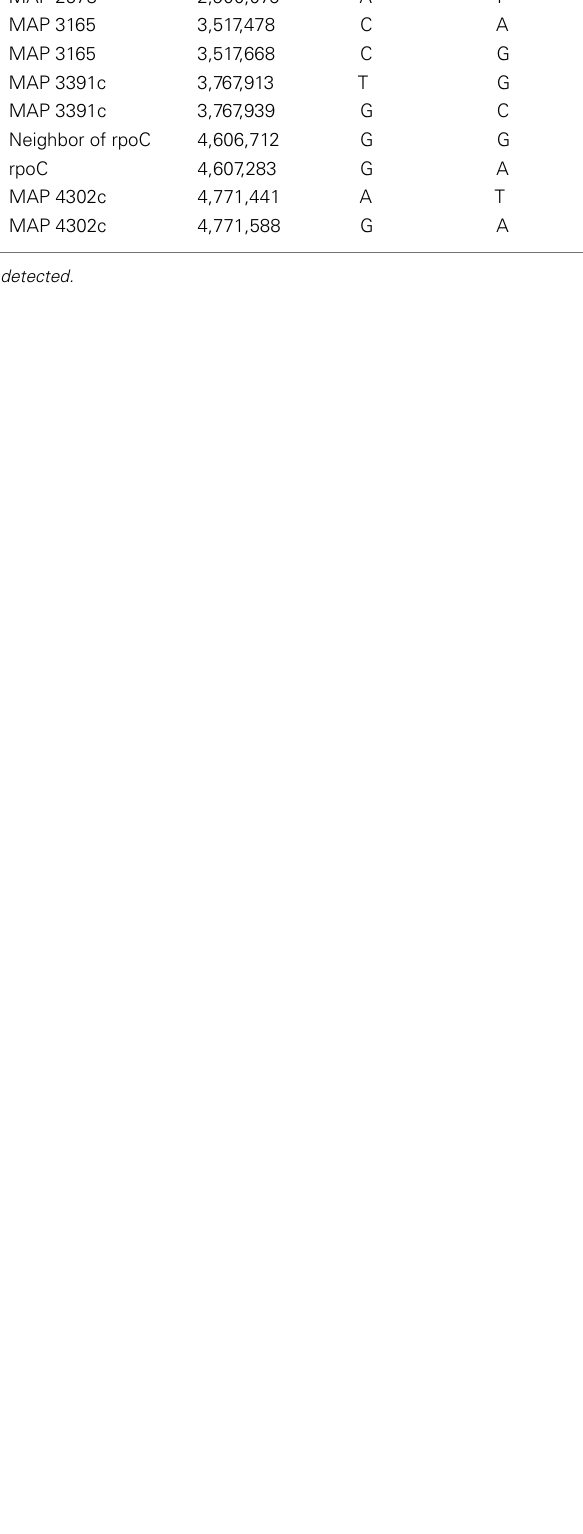
TableA3 |A list of 10 SNPs picked for Sanger sequencing. No.